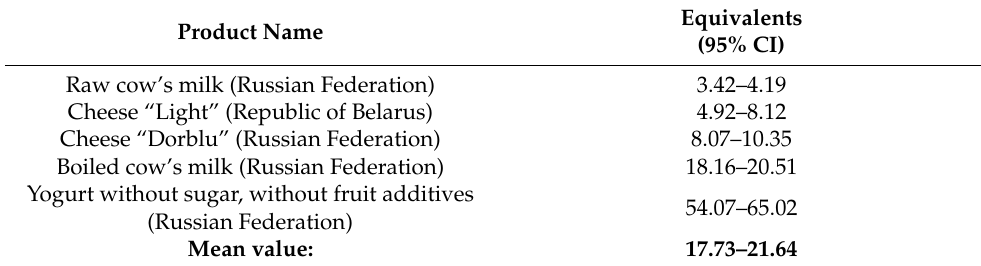
Table 7. ARP values for dairy products and